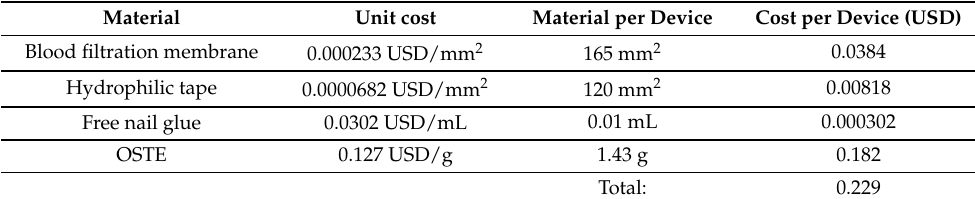
Table A1. Cost estimation of one device in this